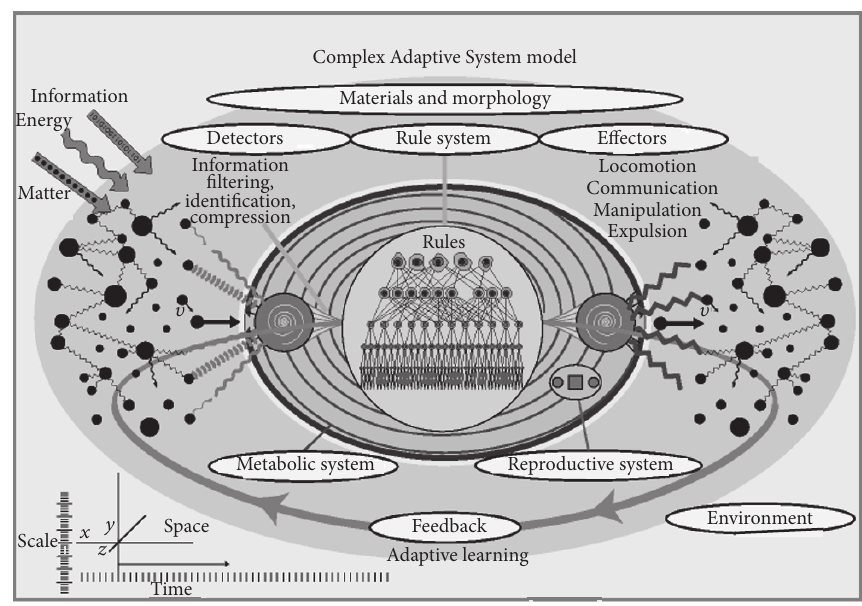
Figure 1: Generic model of a CAS. Source: